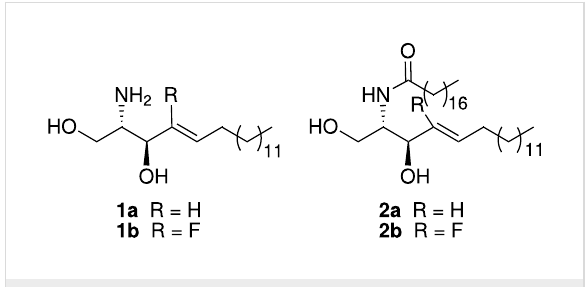
Figure 1: Natural sphingosines 1a , 2a and synthesized fluorinated analogues 1b , 2b .